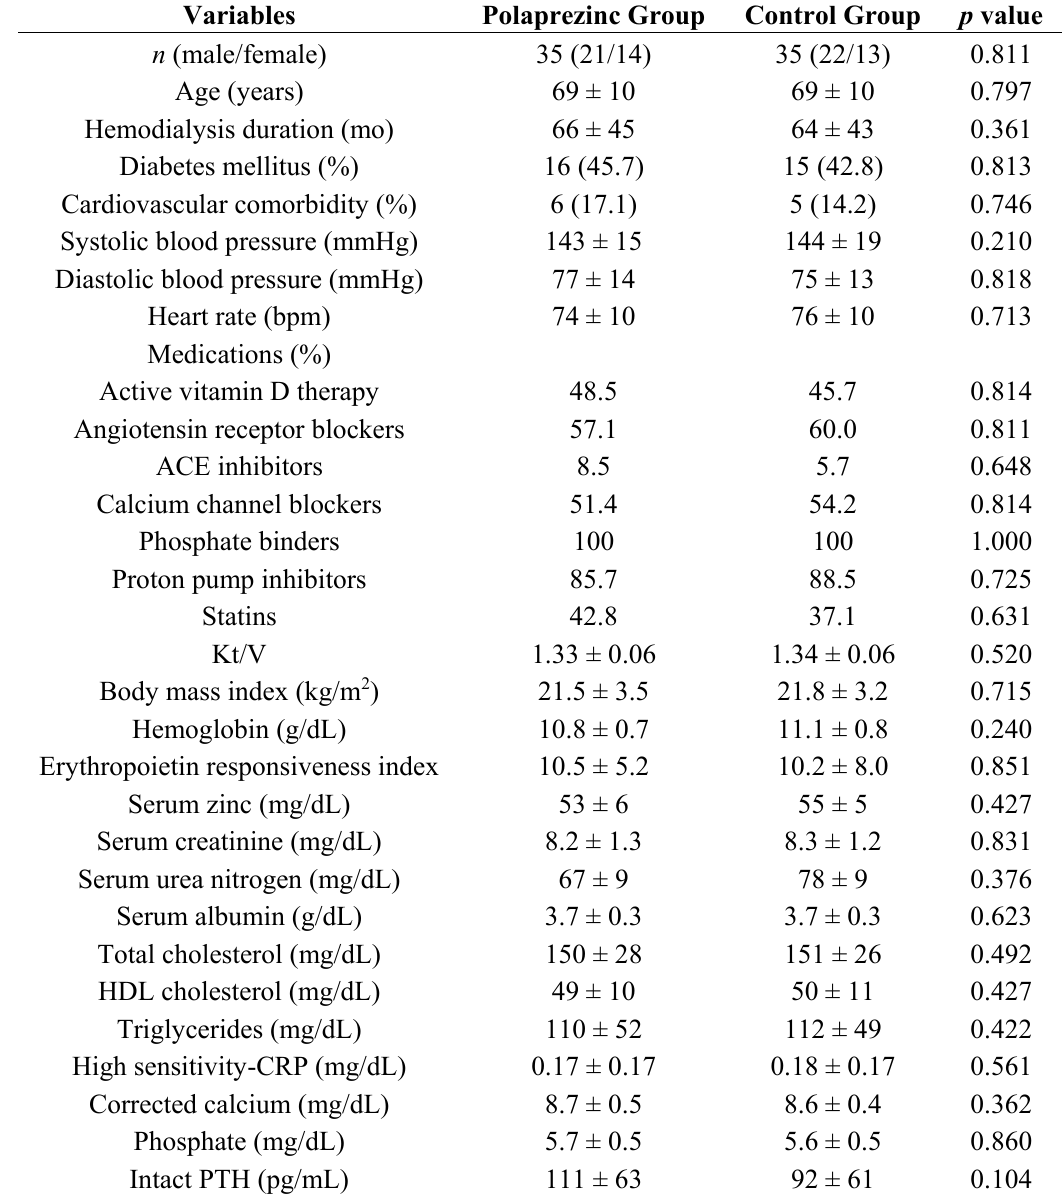
Table 1. Baseline characteristics of the two